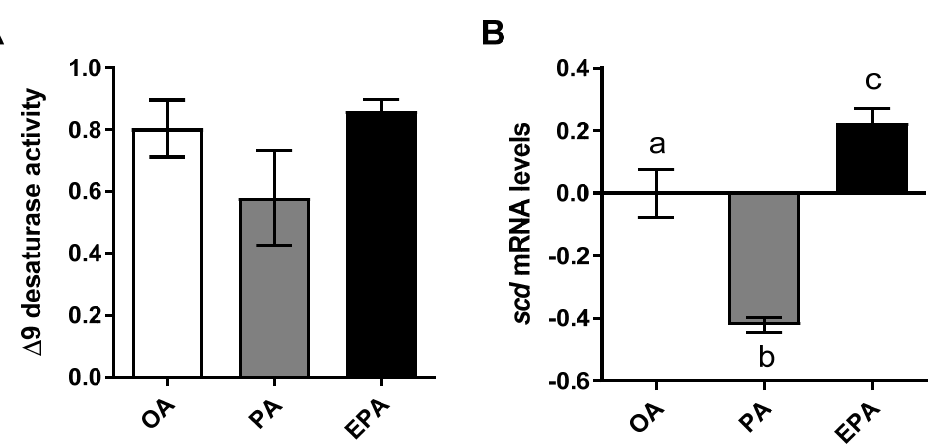
Figure 2. Delta 9 desaturase activity ( A ) and relative changes in transcript levels ( B ) in mature Atlantic salmon adipocytes incubated with oleic, palmitic, or eicosapentaenoic acid for 72 h. Data are shown as mean ± SEM ( n = 3 for ∆ 9 desaturase activity, and n = 4 for the relative changes in transcript levels) and analyzed by one-way ANOVA followed by Tukey’s honestly significant di ff erence test ( p = 0.2197 and p < 0.0001, respectively). Di ff erent letters indicate significant di ff erences between treatments. The activity was calculated based on the 16:0 and 16:1 + 18:1 produced from [1- 14 C] PA. OA = oleic acid, PA = palmitic acid, and EPA = eicosapentaenoic acid. Relative changes in transcript levels were analyzed with real-time qPCR; data are presented as − ∆∆ Ct ± SEM, and the OA group was set to zero.